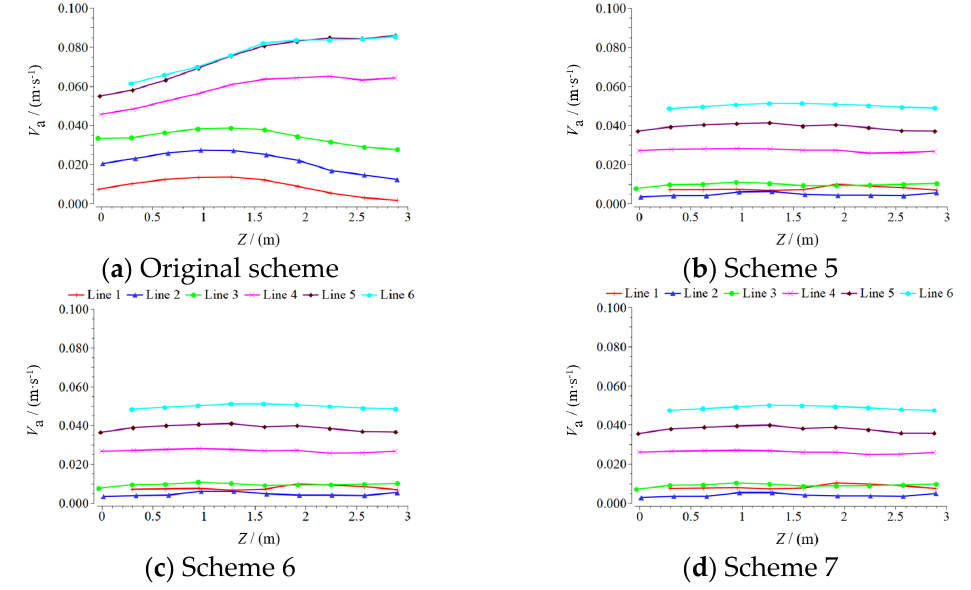
Figure 15. Diagram of axial velocity on the inlet of the sump 3#.